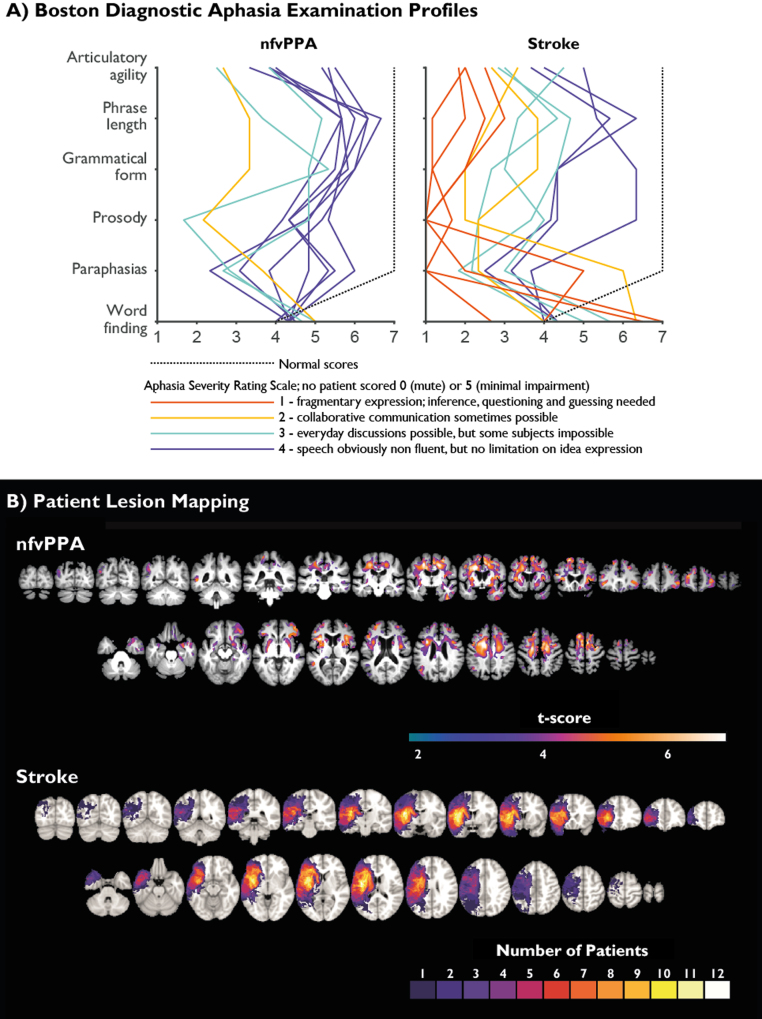
A) Boston Diagnostic Aphasia Examination Profiles for nfvPPA and stroke groups. Normal values illustrated as broken black line. Colour coding of individual profiles based on Aphasia Severity Rating Scale; 1 = red, 2 = magenta, 3 = yellow, 4= blue. No patients had an ASRS of 0 (no usable speech or auditory comprehension) or 5 (minimal discernible handicap). B) Upper: Voxel based morphometry of nfvPPA vs age-matched healthy controls. Coloured regions demonstrate cluster-wise significance at FWE<0.05 with a cluster defining threshold of 0.001 for either grey or white matter volume. Lower: lesion overlap map for the stroke group. (For interpretation of the references to color in this figure legend, the reader is referred to the web version of this article.)